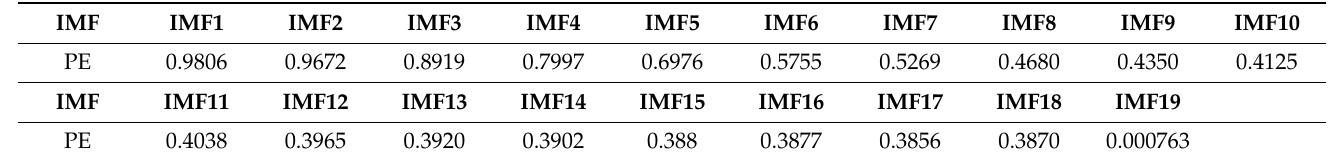
Table 4. The PE value of IMF components.